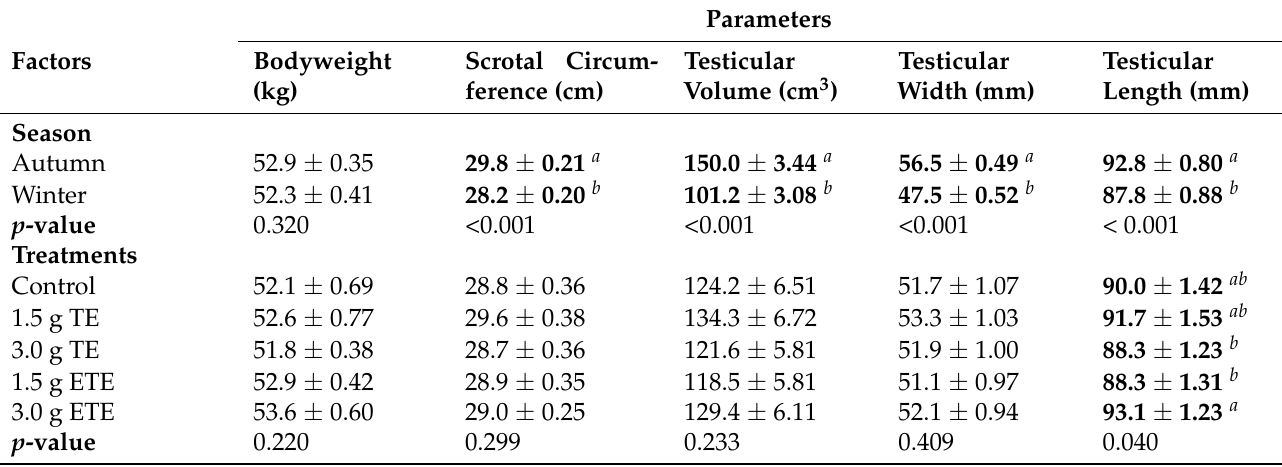
Table 1. Effects of season and tannin supplementation on bodyweight and testicular measurements (Mean ± SE) of South African Mutton Merino